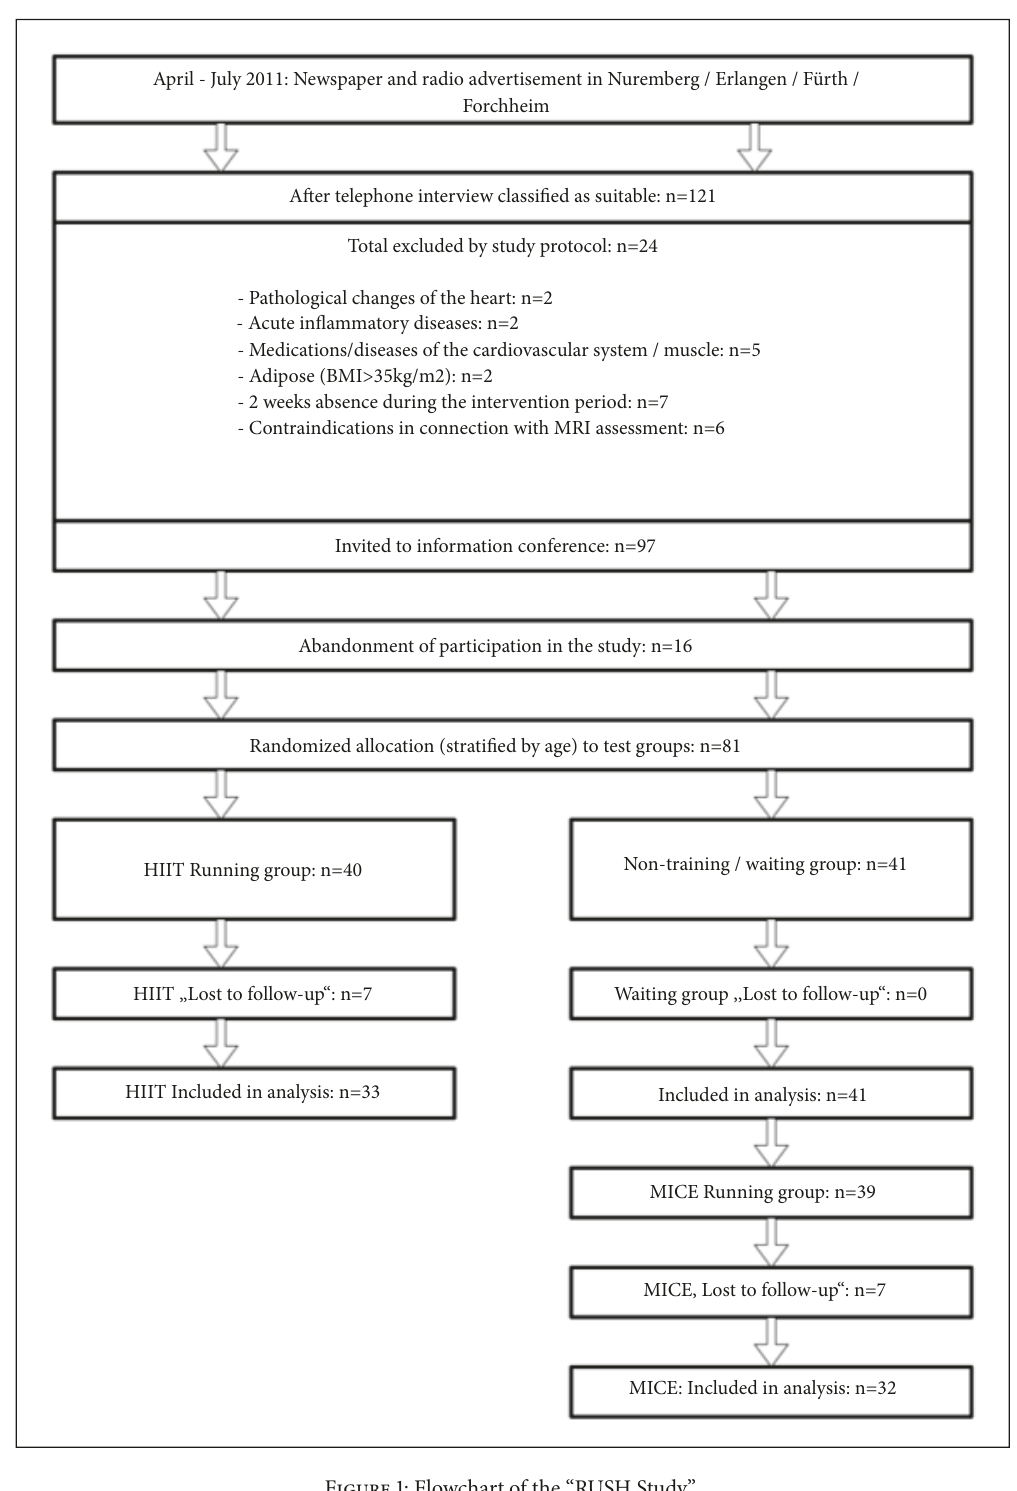
Figure 1: Flowchart of the “RUSH